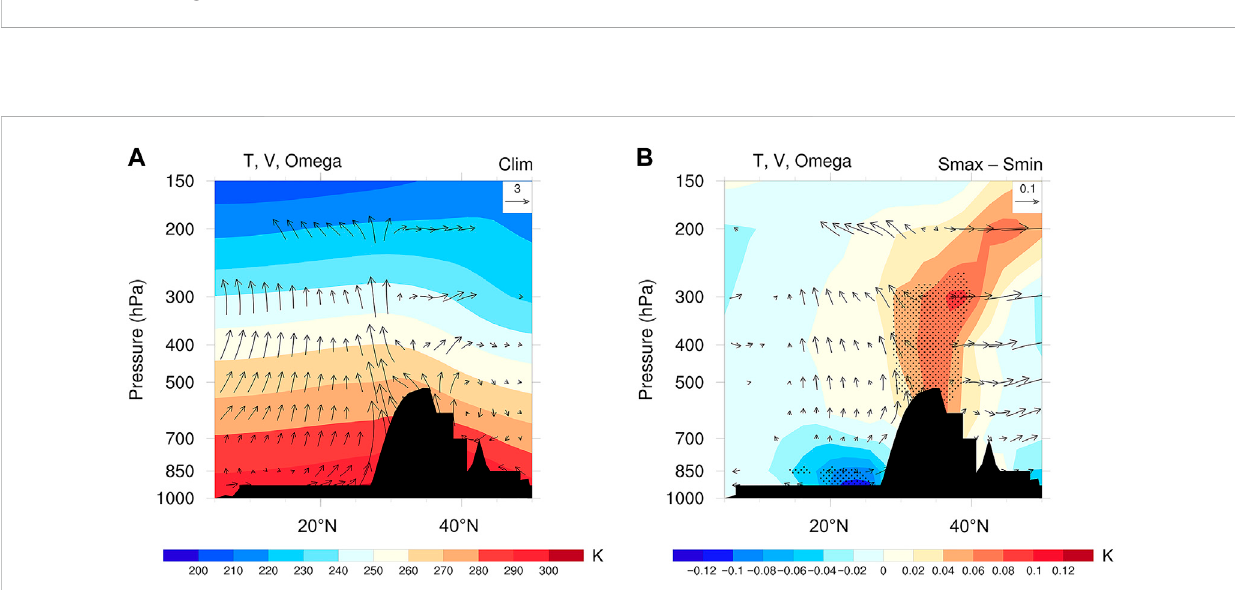
FIGURE 6 (A) Zonally averaged (77.5 ° – 87.5 ° E) climatological JJA mean pressure – latitude cross section of temperature (shading, K), vertical velocity (vectors, 0.02 Pa s − 1 ),andmeridionalwinds(ms − 1 )duringtheperiod1976 – 2005. (B) Sameas (A)